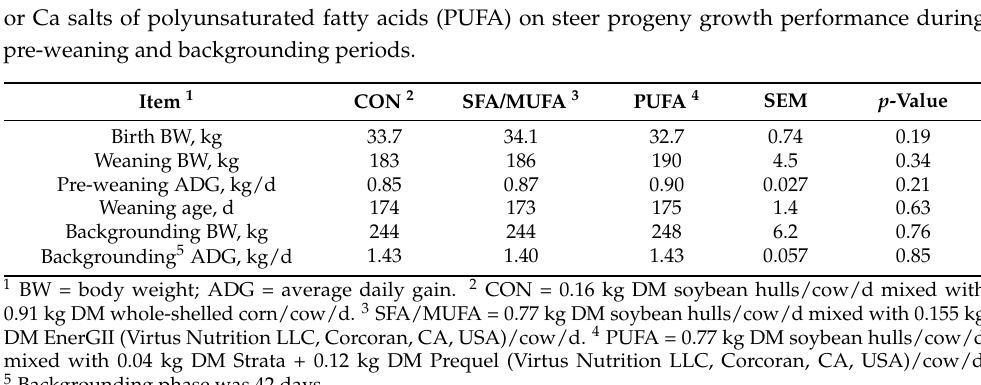
1 Data are presented as relative concentration per 100 µ L plasma to internal standard C23:0; at birth plasma samples were collected from steers 4 ± 2.2 d of age. 2 CON = 0.16 kg DM soybean hulls/cow/d mixed with